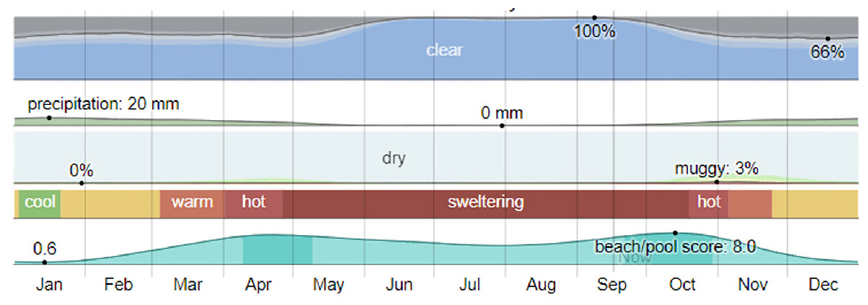
Fig. 1. Average weather in